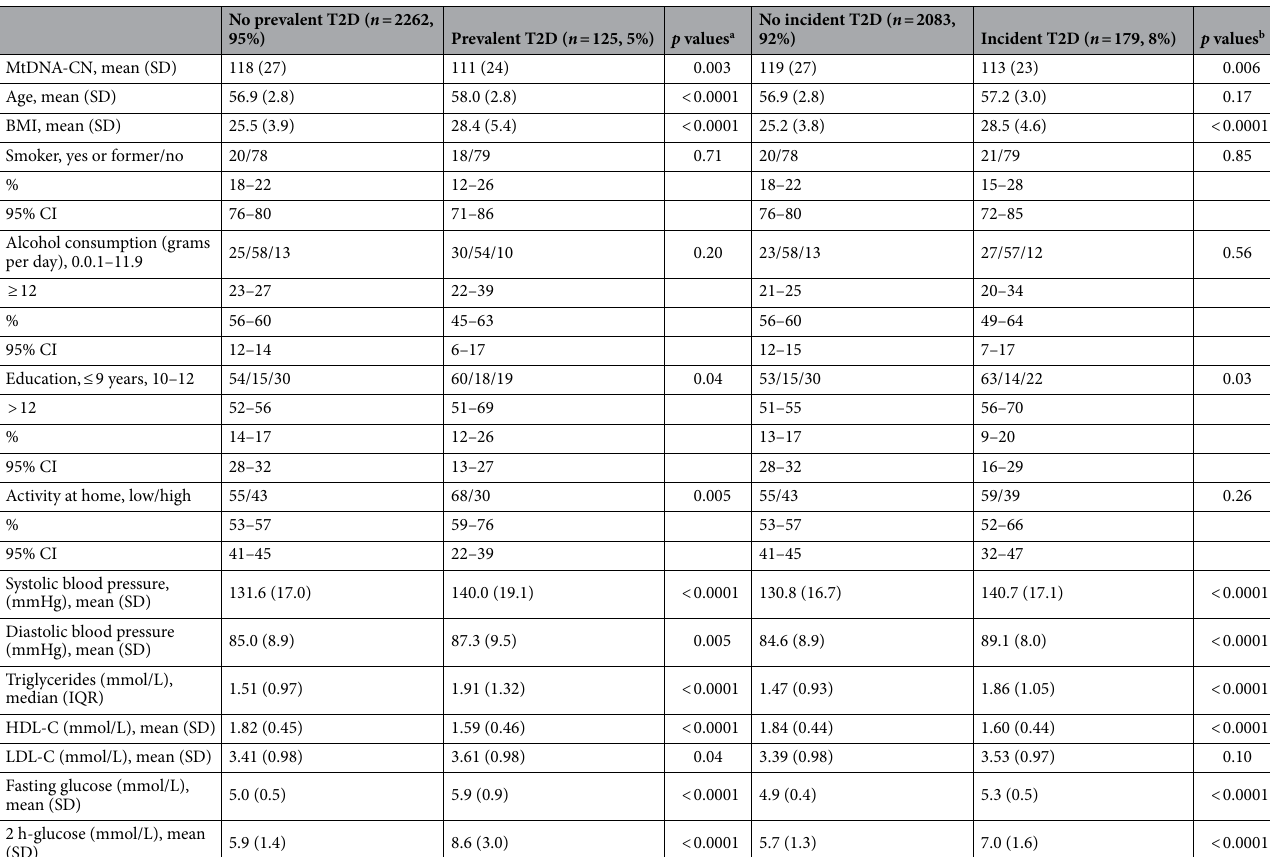
Table 2. Baseline characteristics and mtDNA-CN levels in study subjects with and without prevalent and incident T2DM. a Test for difference between no prevalent and prevalent T2DM using Student’s t-test, Chi- square test and Wilcoxon rank-sum test. b Test for difference between no incident and incident T2DM using Student’s t-test, Chi-square test and Wilcoxon rank-sum test.